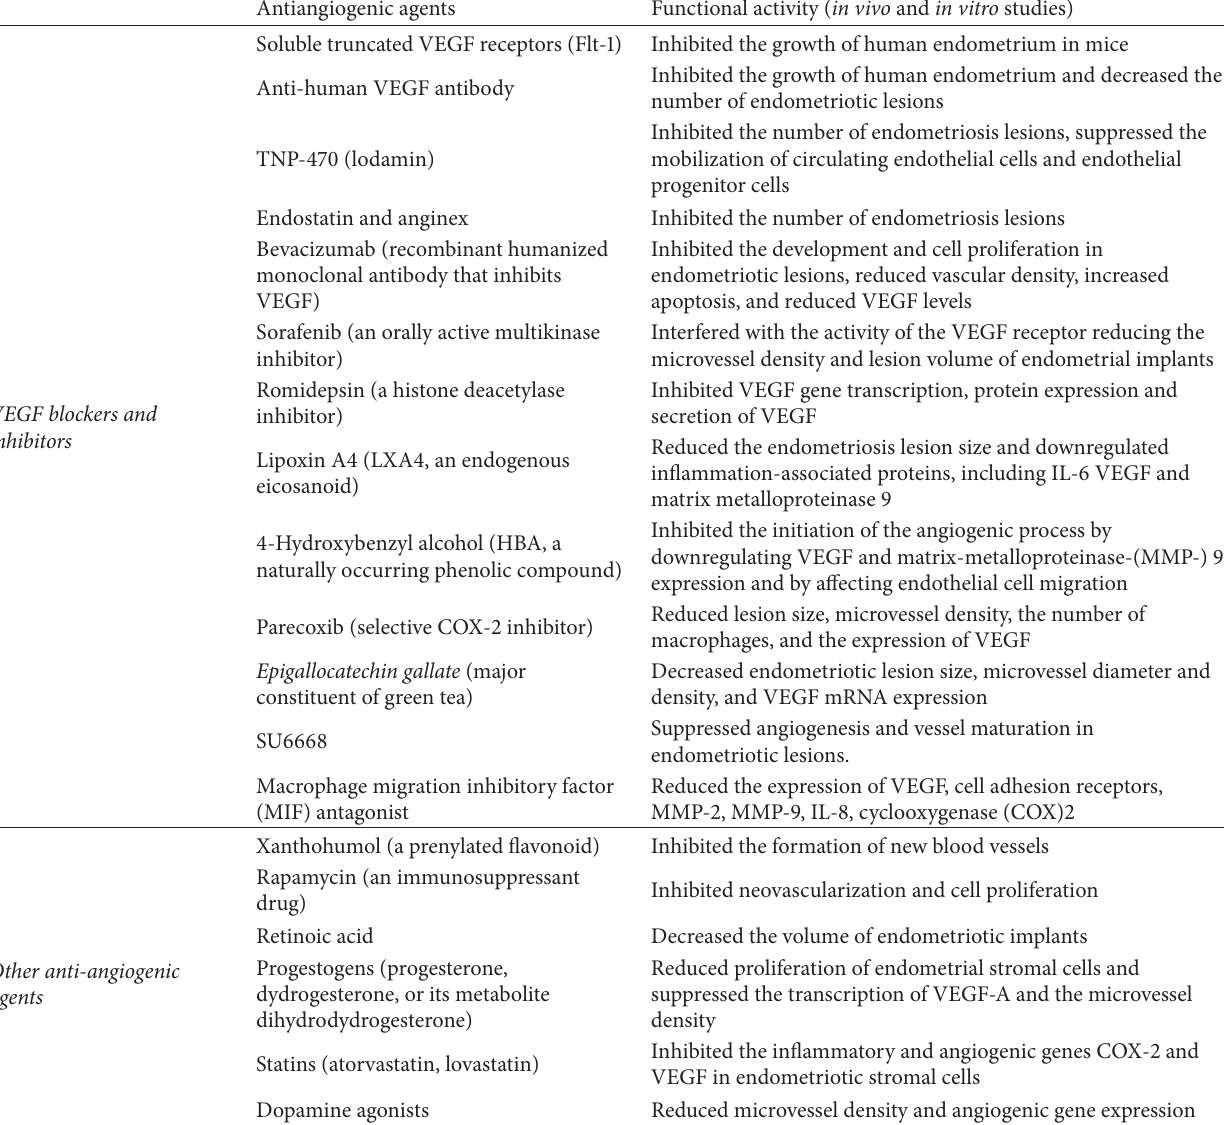
Table 1: Antiangiogenic